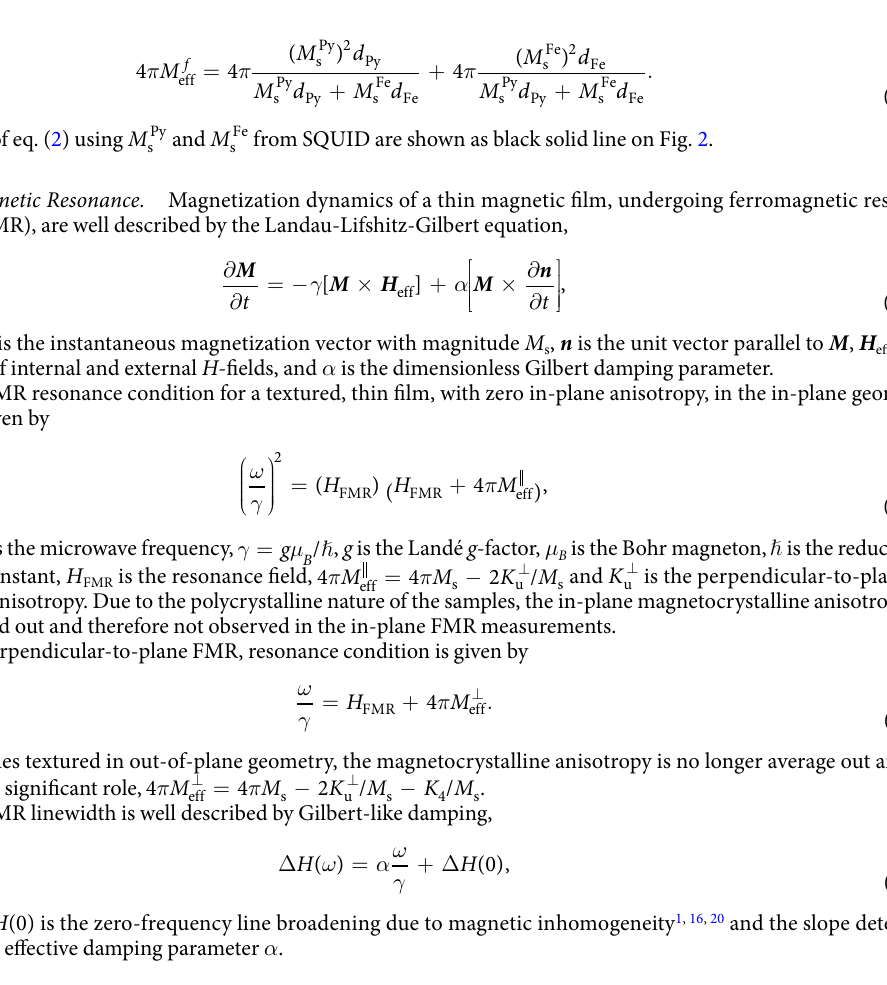
The effective saturation induction, 4 π M eff , of a bilayer system assuming no anisotropy can be determined using 16 ,